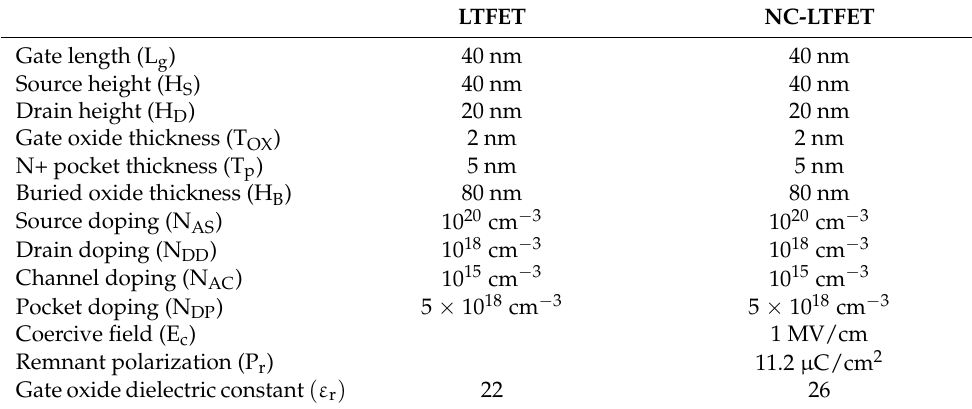
Table 1. Device parameters of LTFET and